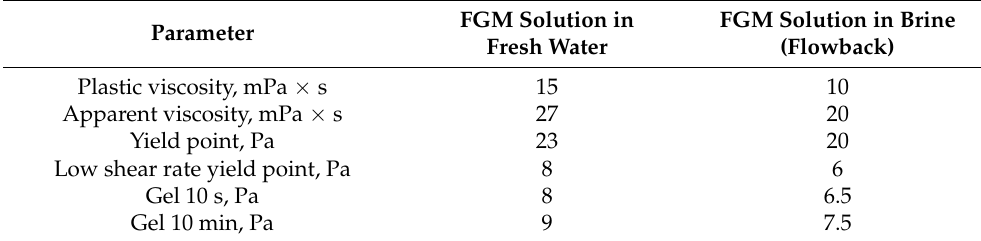
Table 5. Parameters of FGM solutions in water and in brine